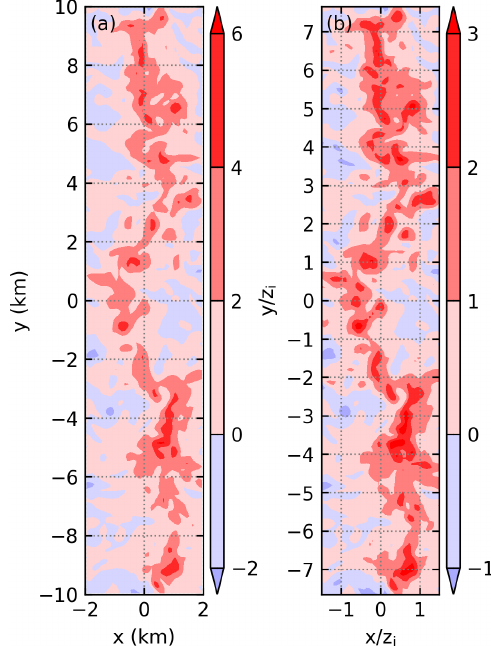
Figure 8. Horizontal cross section of (a) dimensional vertical ve- locity (ms − 1 ) and (b) non-dimensional vertical velocity at z = 0 . 66km and at t = 7h 50min in simulation